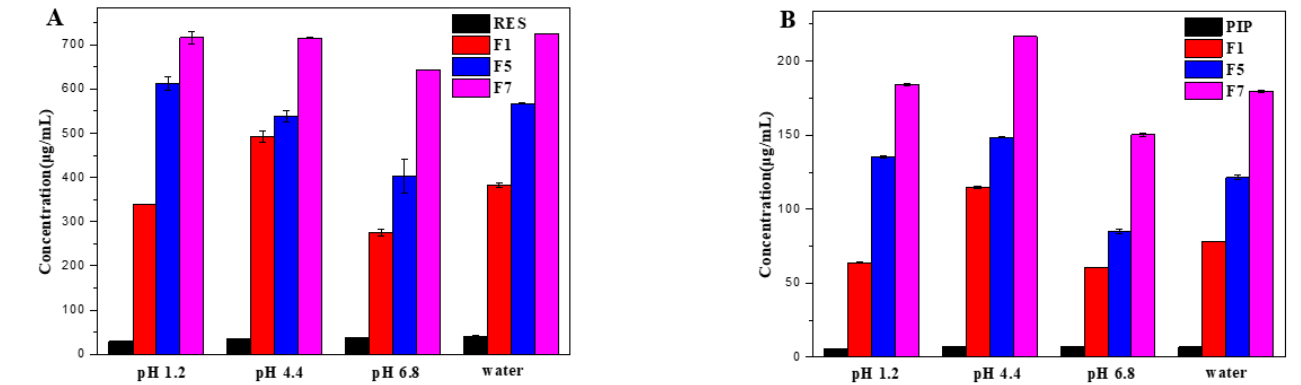
10 of 13 Figure 6. DSC profiles of RES, PIP, HP- β -CD, physical mixture, and representative spray-dried microcapsules (F5). 3.6. Equilibrium Solubility Study